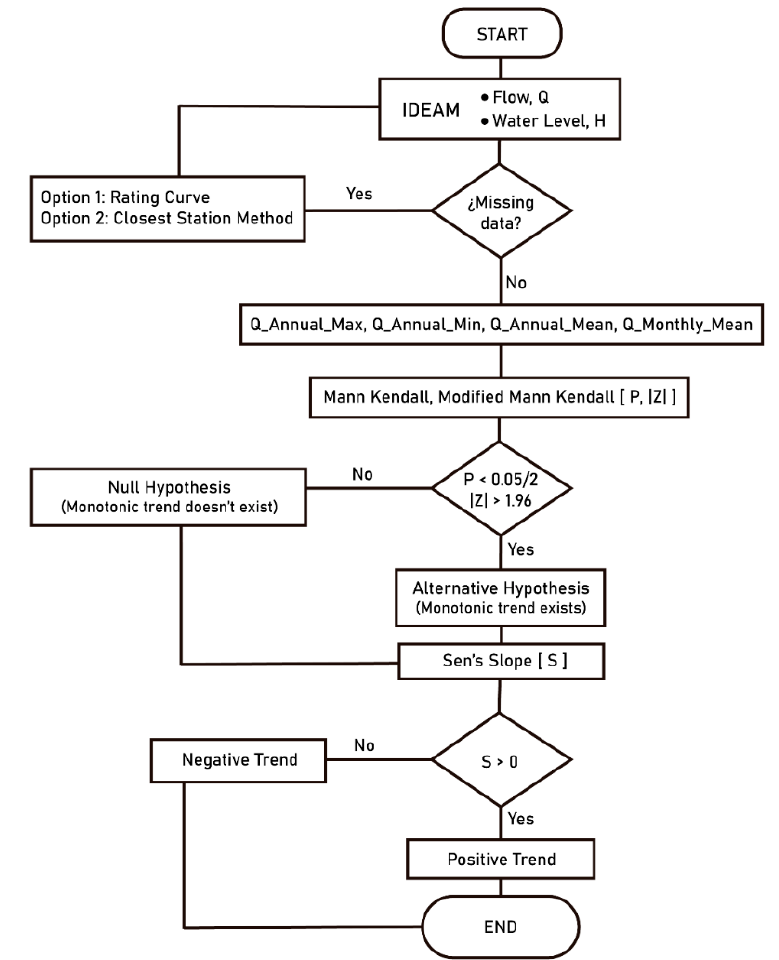
Figure 2. Flowchart describing a series of steps for trend analysis.